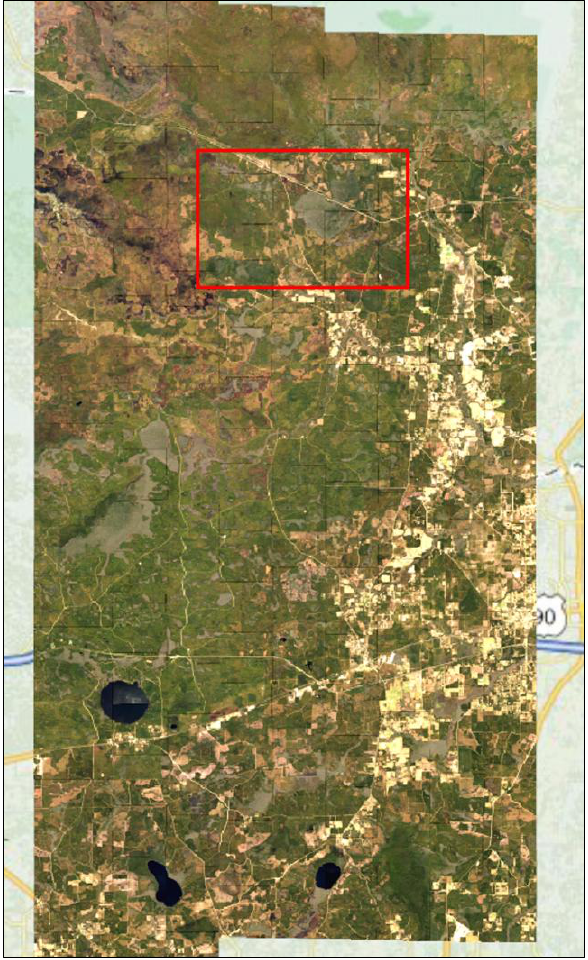
Figure 3. Overview of a DMC-II flight session in Baker County, Florida, with all radiometric corrections applied. The rectangle marks the area of Figure